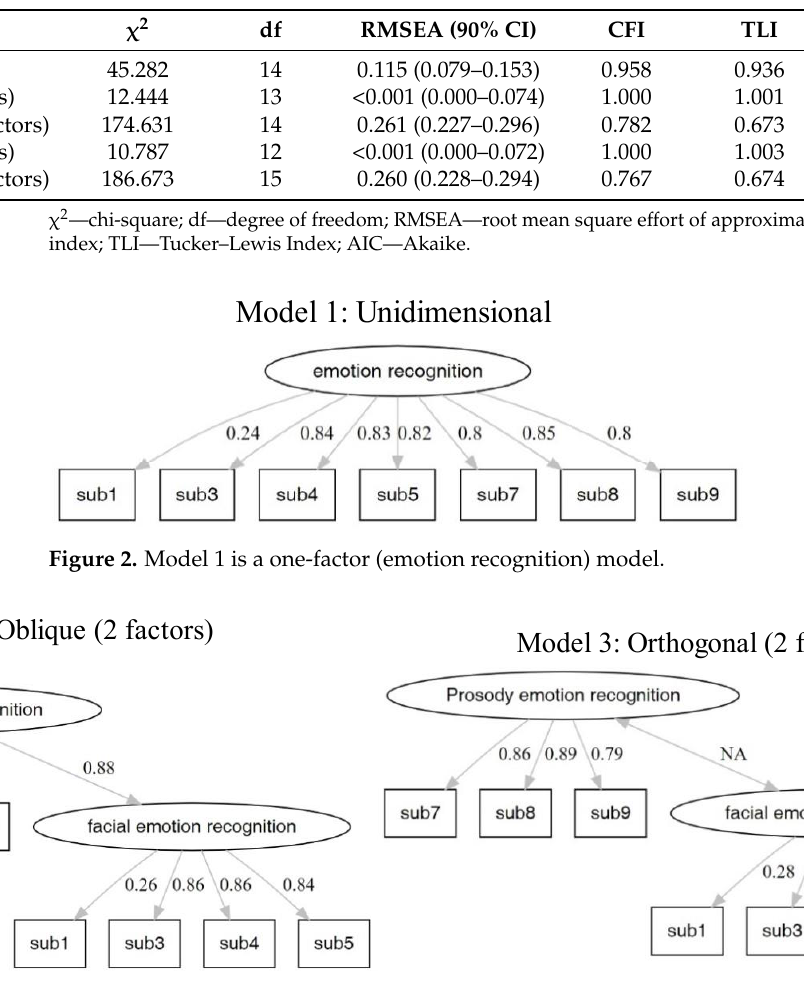
Table 5. Confirmatory factor analysis of MMER app with different models.